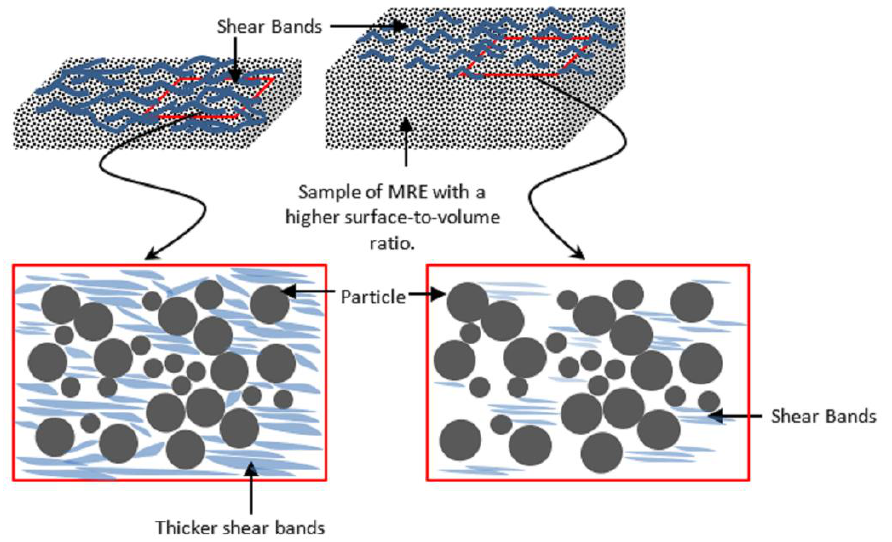
Figure 4. Schematic representation of the proposed mechanism for MRE under strain localization and shear band development.